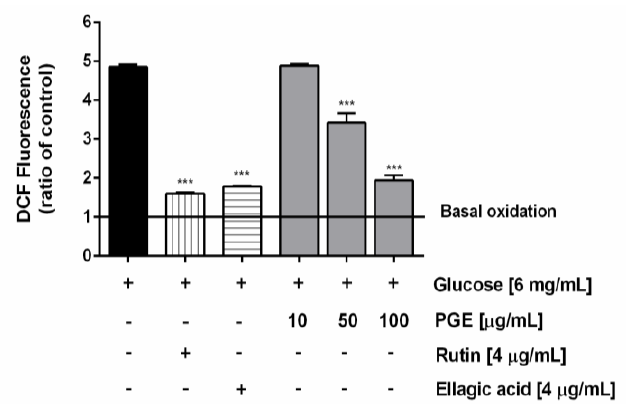
Figure 6. Effect of the ethyl acetate extract, obtained by Soxhlet from the waste peel of Punica granatum L. var. Dente di Cavallo DC2 (PGE), rutin, and ellagic acid on the reactive oxygen species (ROS) levels induced by hyperglycemia conditions in AGS cells. ROS levels are expressed as oxidation index with respect to the basal levels. Data are mean ± SE from at least two independent biological replicates ( n = 2). *** p < 0.001 vs Glucose [6 mg/mL] by ANOVA followed by Dunnett’s Multiple Comparison Post Test.